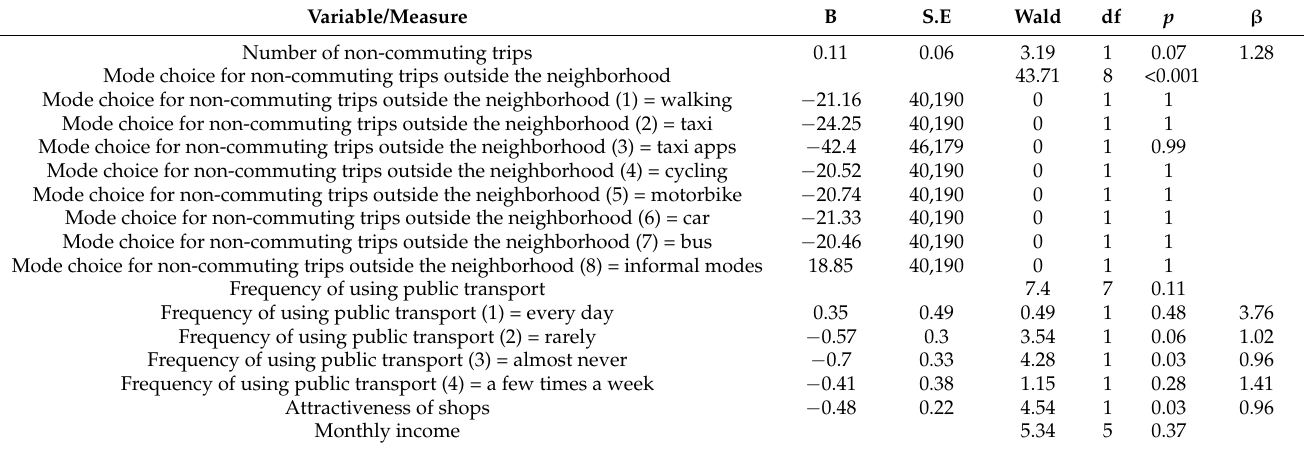
Table 6. Binary logistic model for choice of destination of shopping trips for residents of sprawled districts. Variable/Measure B S.E Number of non-commuting